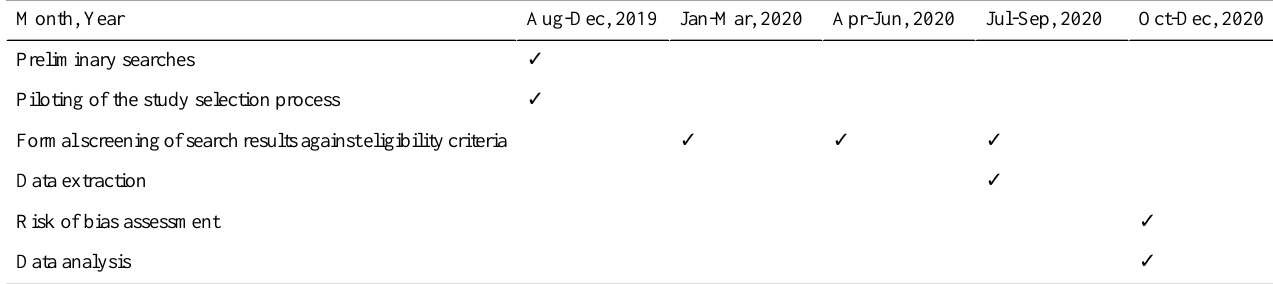
Table 2. Progress and timeline (adapted from the PROSPERO International Prospective Register of Systematic